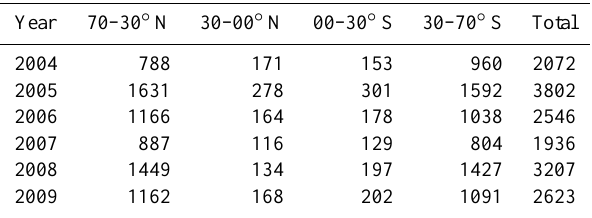
Table 3. The number of ACE-FTS occultations used for each lati- tude band and